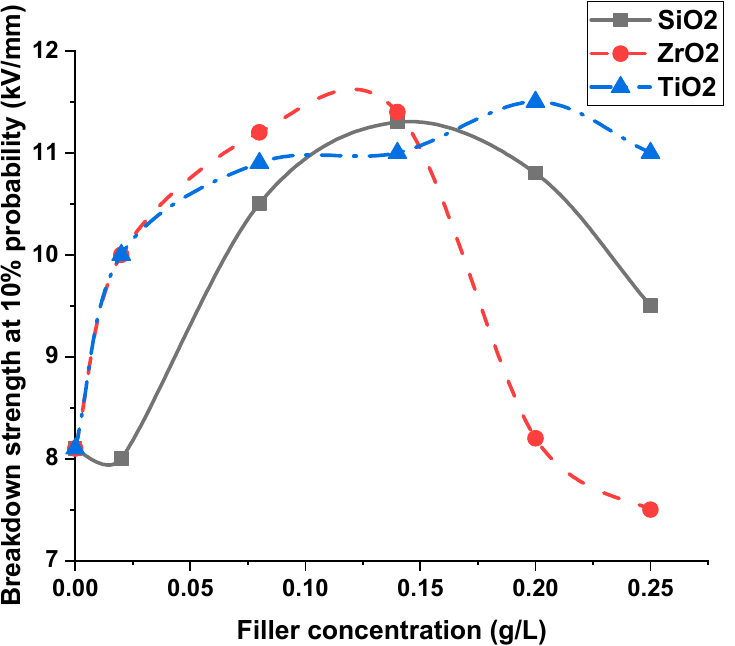
Figure 7. Breakdown strength at 10% probability of transformer oil containing different types of nanoparticles (SiO 2 , ZrO 2 and TiO 2 ).